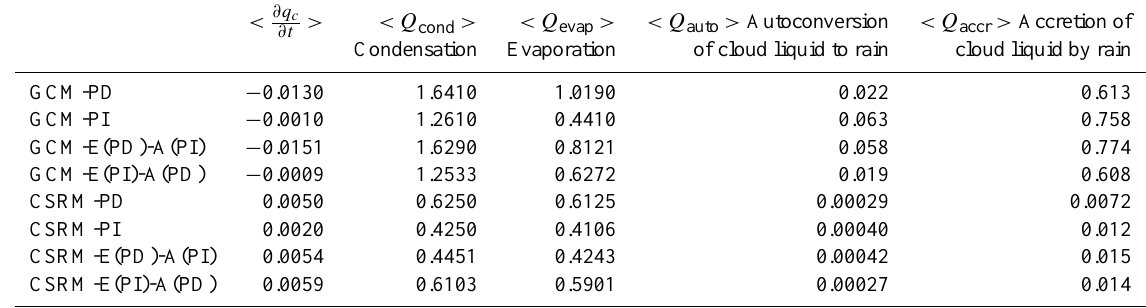
Table 3. Domain-averaged budget terms of cloud liquid (mm) during the time period when stratocumulus clouds dominate before 00:00LST on 17